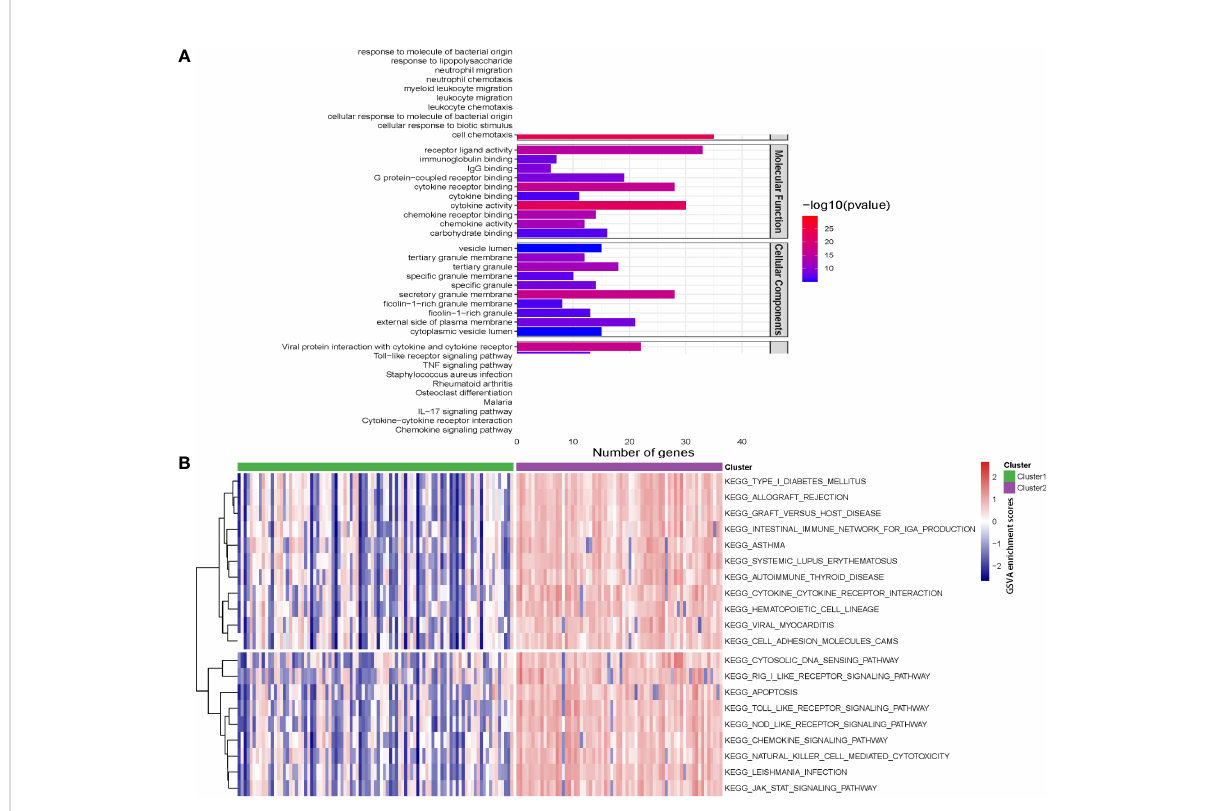
FIGURE 10 Pathway enrichment analysis and gene set variation analysis (GSVA) for two Crohn ’ s disease clusters. (A) The top 10 enriched gene sets by GO pathway (biological process, molecular function and cellular components) and KEGG pathway analysis according to enrichment scores. (B) Heatmap showing enriched pathways for single hub gene through